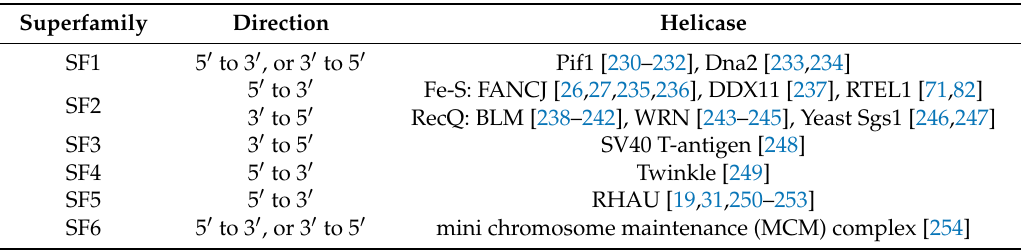
Table 3. The different families of